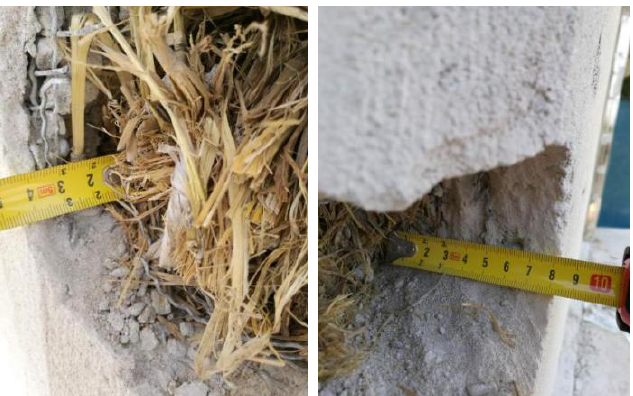
Figure 11. Straw conditions behind opening locations with thin rendering thickness ( left ) and thick rendering thickness ( right ).